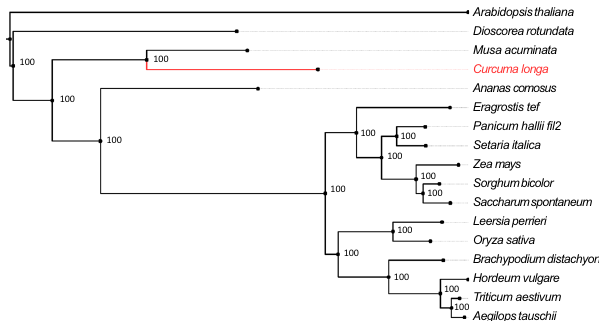
Fig. 1 Phylogenetic position of C. longa . Phylogenetic tree of C. longa with 15 other selected species and Arabidopsis thaliana as an outgroup